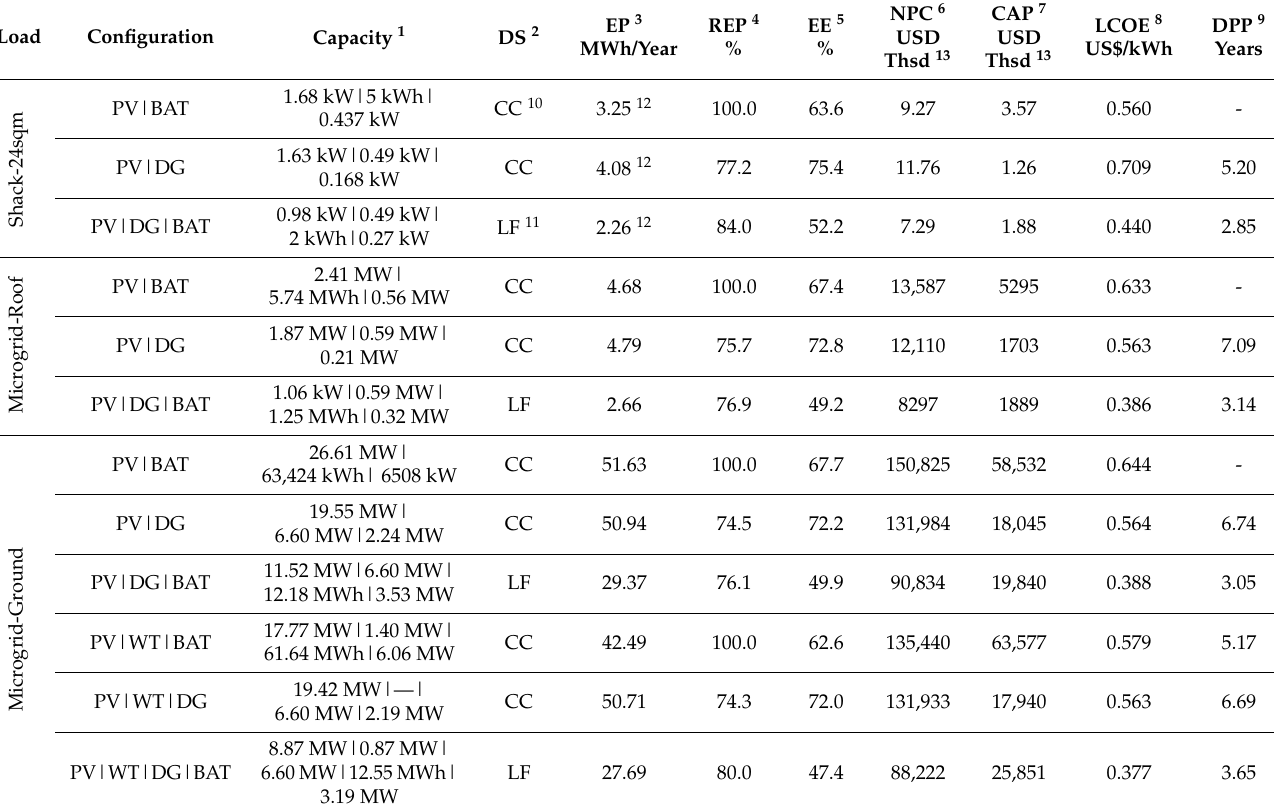
Table 8. Techno-economic comparison of different energy system configurations *.